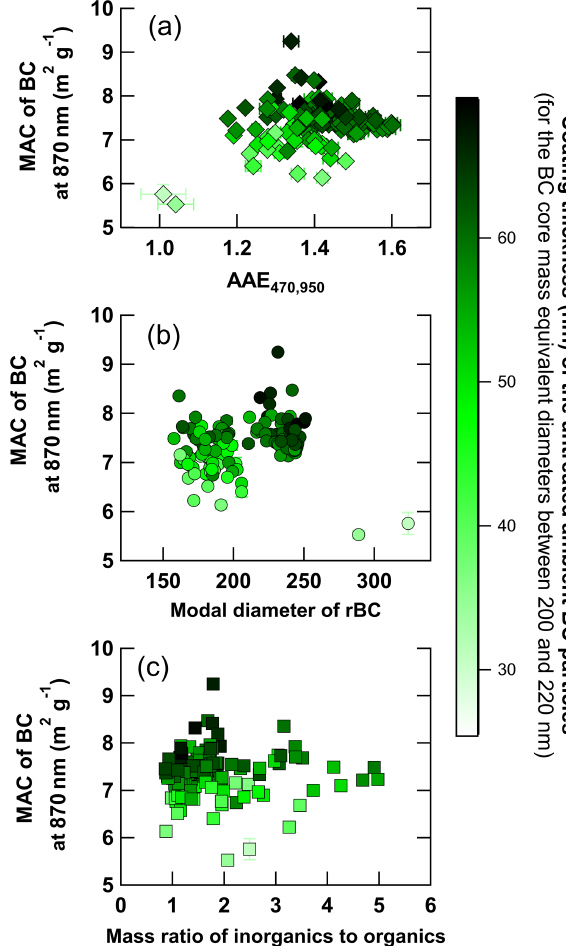
Figure 7. Time-resolved MAC BC values of untreated ambient BC particles at 870nm wavelength calculated at 3h resolution plotted against (a) the absorption Ångström exponent, AAE 470 , 950 , be- tween 470 and 950nm wavelength; (b) the modal diameter of the BC core mass size distributions ( D rBC ) (expressed as mass equiv- alent diameter); and (c) the ratio of non-refractory inorganic to or- ganic components measured in near-PM 1 by the